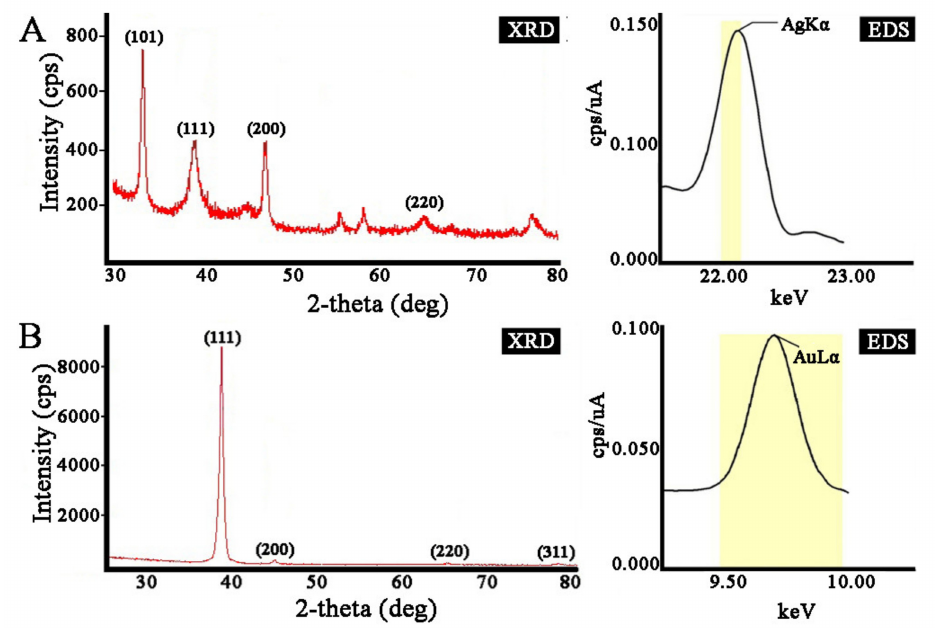
Figure 4. X-ray diffraction (XRD) and energy dispersive X-ray (EDX) analysis of AgNPs ( A ) and AuNPs ( B ) synthesized with L . erythrorhizon callus